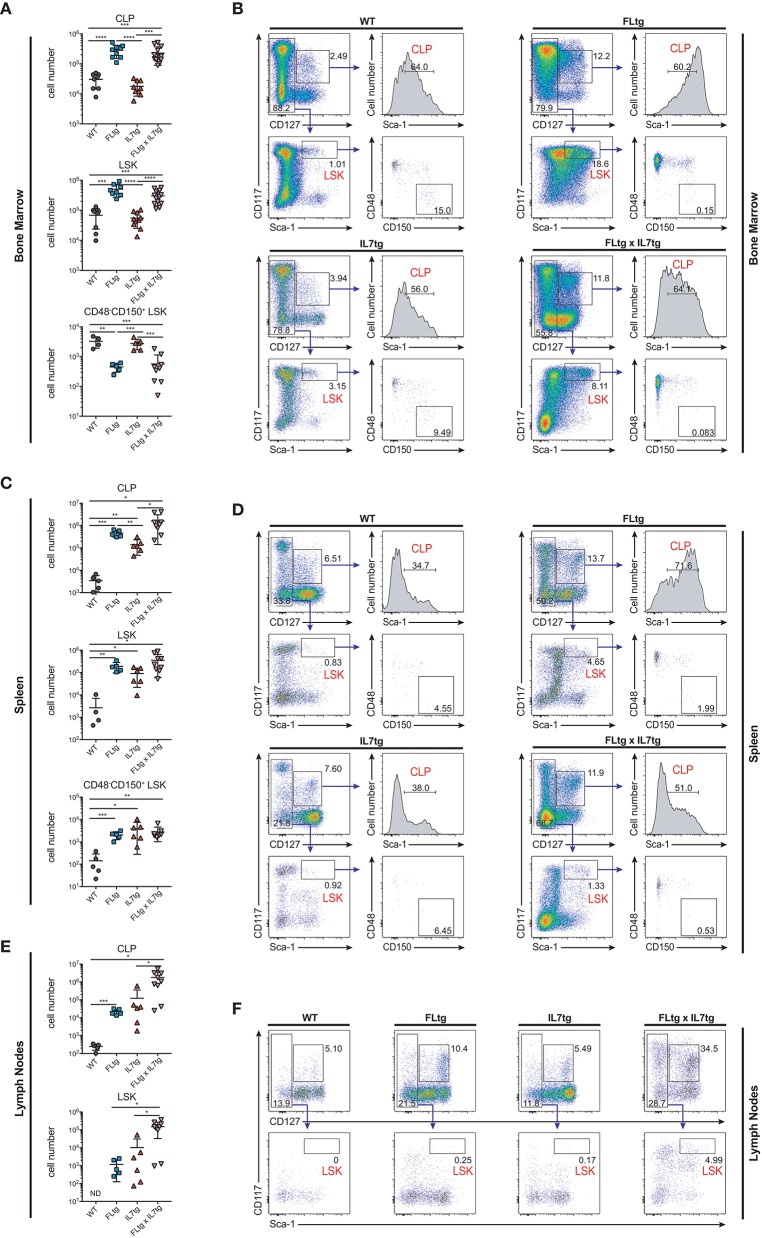
Increased numbers of CLP and LSK in the spleen and lymph nodes of FLtgxIL7tg mice. (A) Numbers of Lin−CD117intSca1intCD127+ (CLP), Lin−CD127−CD117+Sca1+ (LSK) and Lin−CD127−CD117+Sca1+CD48−CD150+ LSK in the bone marrow of WT, FLtg, IL7tg, and FLtgxIL7tg mice. (B) Representative FACS plots for the identification of CLP, LSK, and CD48−CD150+ LSK in the bone marrow (femurs and tibias) of WT, FLtg, IL7tg, and FLtgxIL7tg mice. Gate numbers indicate frequencies of parent gate. In every panel the upper left plot (CD117 vs. CD127) shows live, Lineage− cells. (C) Numbers of CLP, LSK and CD48−CD150+ LSK in the spleens of WT, FLtg, IL7tg, and FLtgxIL7tg mice. (D) Representative FACS plots for the identification of CLP, LSK, and CD48−CD150+ LSK in the spleens of WT, FLtg, IL7tg, and FLtgxIL7tg mice. Gate numbers indicate frequencies of parent gate. In every panel the upper plot (CD117 vs. CD127) shows live, Lin- cells. (E) Numbers of CLP and LSK in the LN of WT, FLtg, IL7tg, and FLtgxIL7tg mice. (F) Representative FACS plots for the identification of LSK in the LN of WT, FLtg, IL7tg, and FLtgxIL7tg mice. Gate numbers indicate frequencies of parent gate. In every panel the upper plot (CD117 vs. CD127) shows live, Lin- cells. *p < 0.05, **p < 0.01, ***p < 0.001, and ****p < 0.0001. Error bars indicate standard deviation.